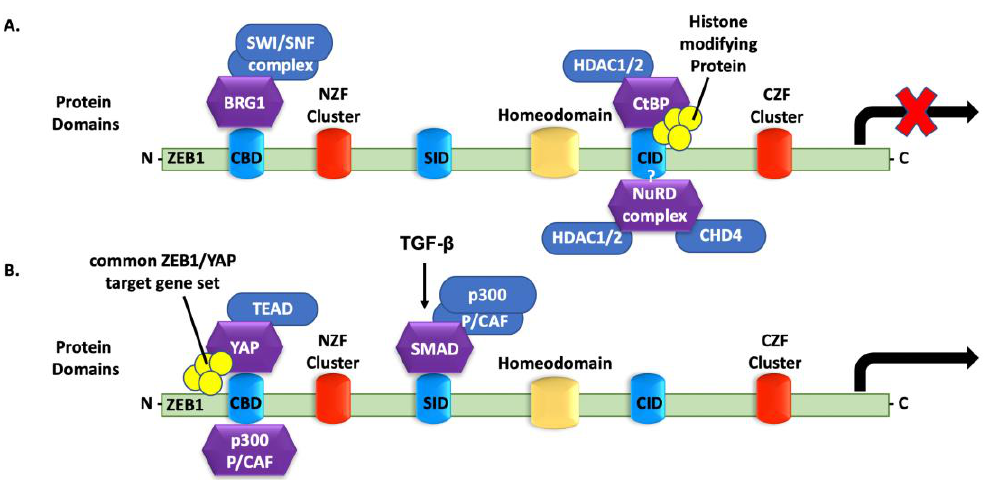
Figure 3. Transcriptional cofactors are required for the ZEB1 function. ( A ) ZEB1 interacts with co- repressors to repress the transcription of their target genes. BRG1 binds to the CBD, and CtBP binds to the CID, but the binding site of the NuRD complex is still unknown; ( B ) ZEB1 interacts with co- activators to activate the transcription of their target genes. p300-P/CAF and YAP bind to the CBD. P300 forms a complex with Smad (Smad-P300) in response to TGF- β via its SID.